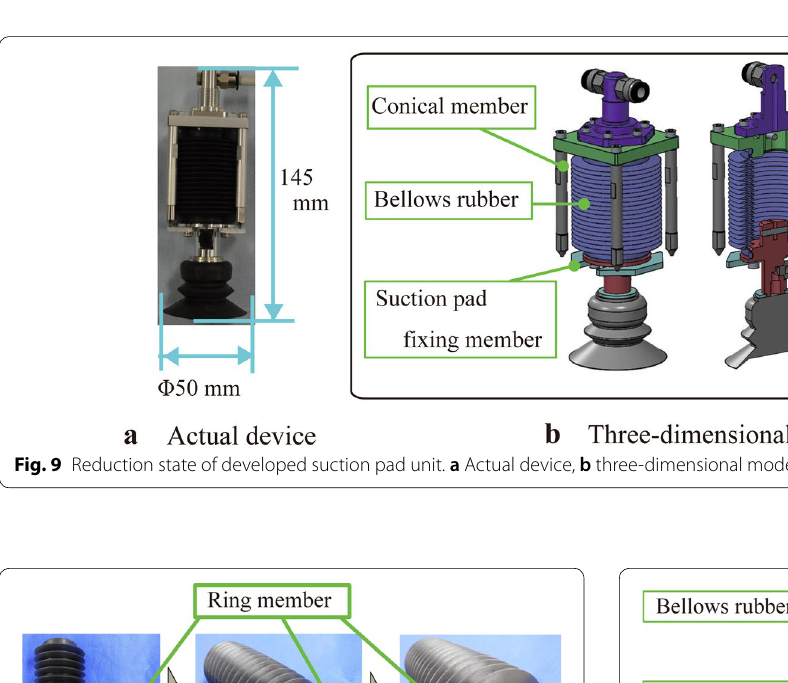
Fig. 8 Extension state of the developed suction pad unit. a Actual device, b three-dimensional model